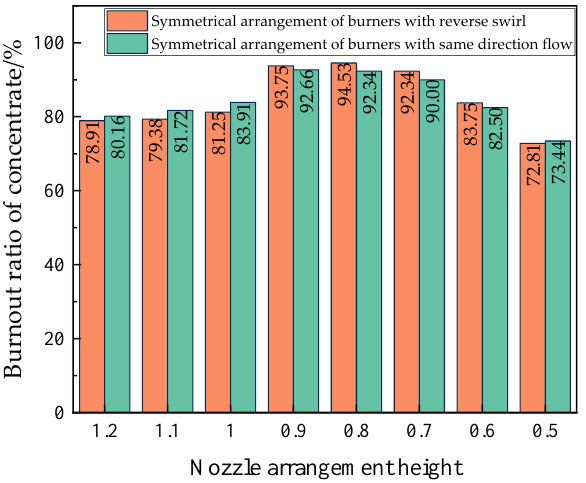
Figure 10. Burnout ratio of concentrated liquid with different nozzle arrangement heights.